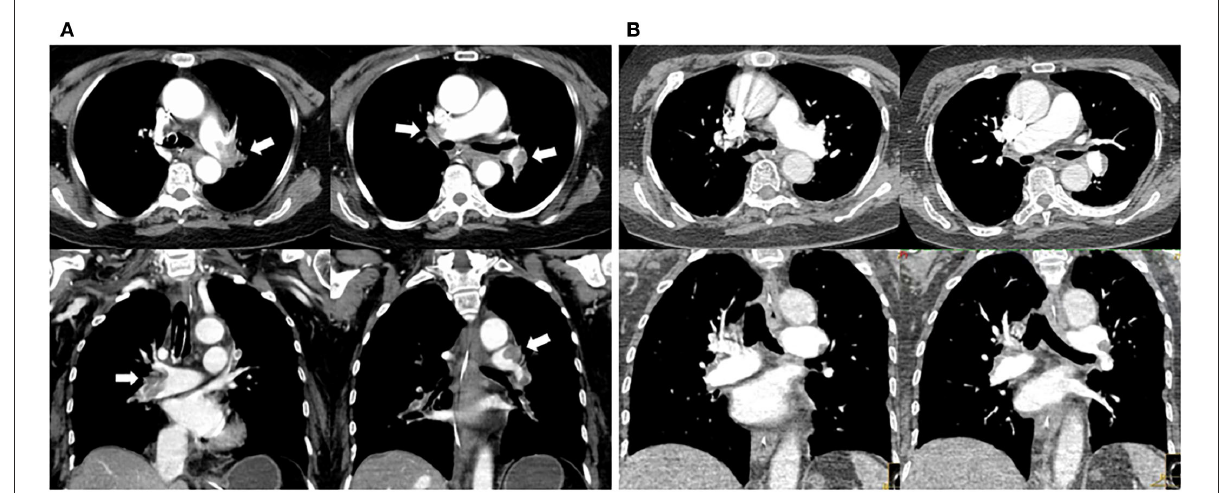
FIGURE1 Changes in pulmonary embolism of CT pulmonary arteriography before and after percutaneous catheter-directed therapy. (A) Multiple filling defects in bilateral pulmonary artery trunks and their branches (white arrow) before CDT. (B) Thrombus eliminated 1 month after CDT and anticoagulation.